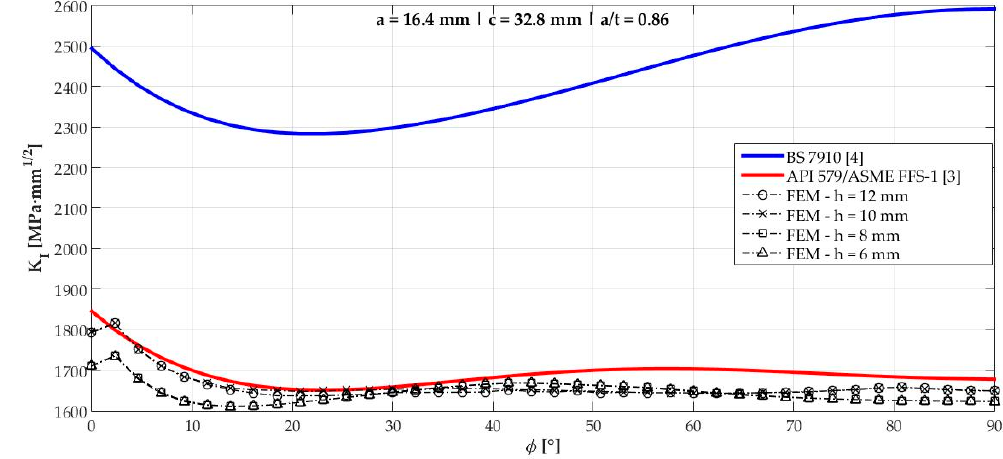
Figure 13. Mode I SIF profiles for crack 8 ( a = 16.4 mm , c = 32.8 mm , and a/t = 0.86 ).